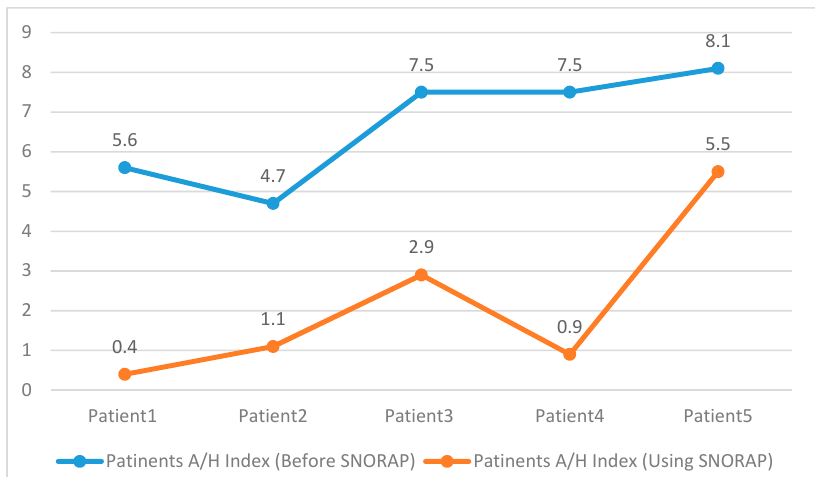
Figure 9. Patient’s Apnea/Hypopnea Index. Table 3. List of p values of statistically significant parameters.